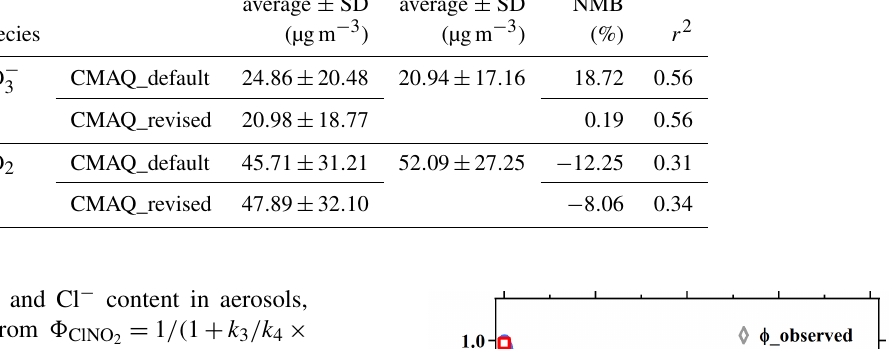
Table 2. Statistical summary and comparison of the observed species (nitrate and NO 2 concentrations) with values predicted from different parameterization. NMB represents the normalized mean bias. Simulated Observed